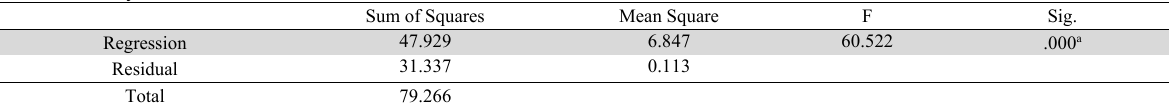
Regression coefficient Unstandardized Coefficients Standardized